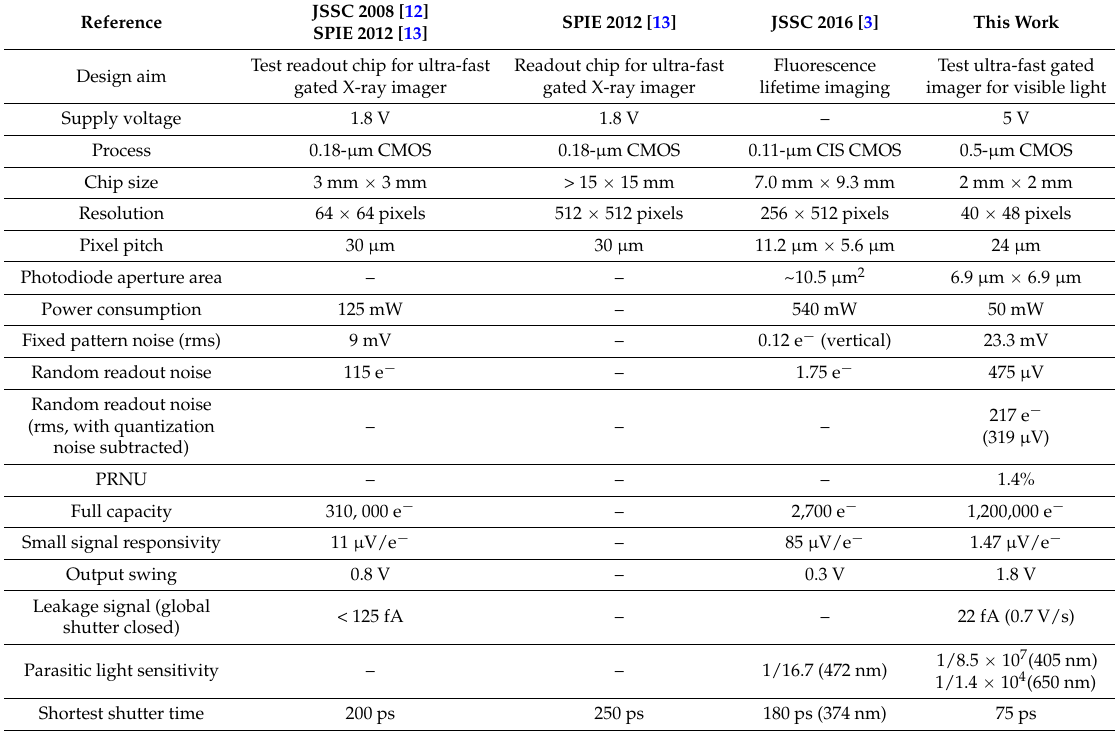
Table 1. Comparison with previous ultra-fast gated CMOS image